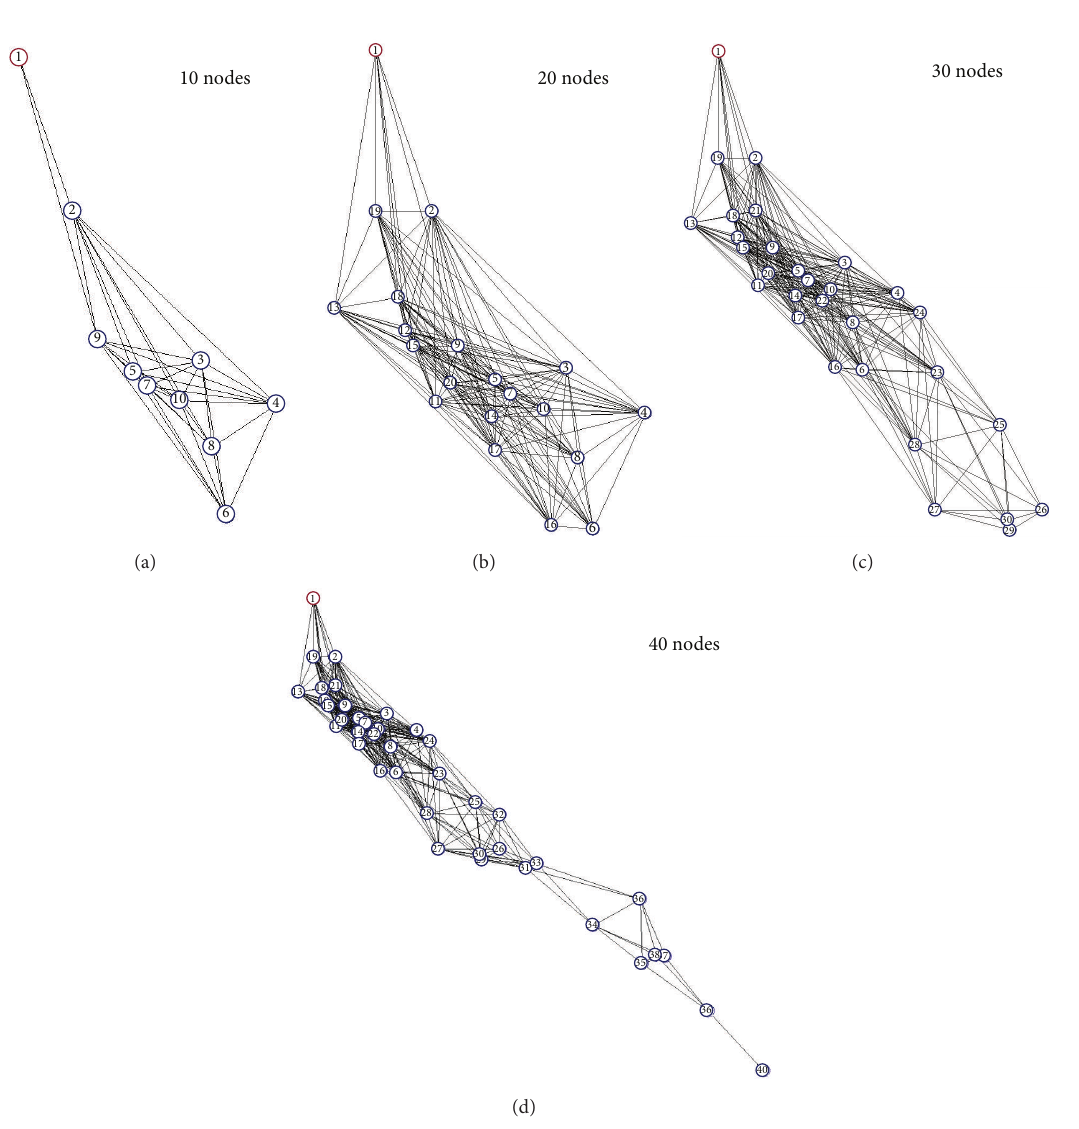
Figure 14: Experiment